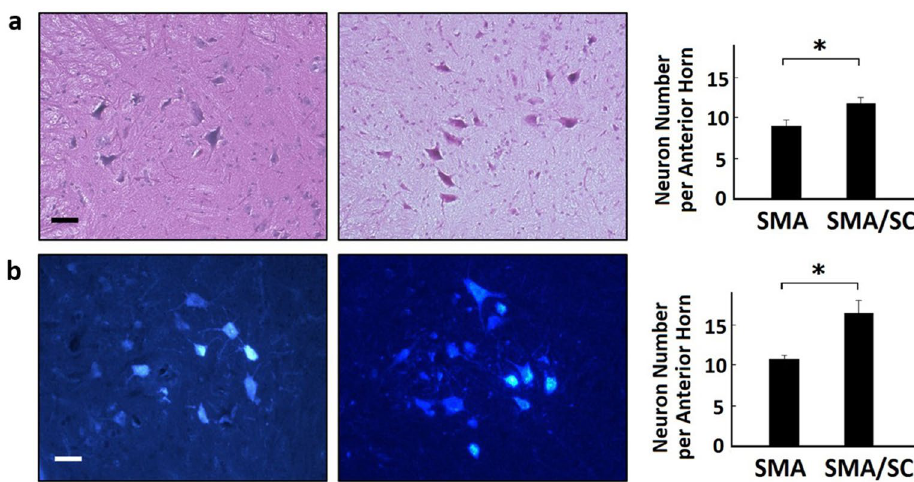
Figure 10. Comparison of neuron in SMA mice with or without hAFSC transplantation. n = 16. (a) H&E staining of tissue from spinal cord. (b) Methylene blue staining of tissue from spinal cord. More neurons per anterior horn were detected in SMA mice with hAFSC transplantation. hAFSC human amniotic fluid stem cell, SMA spinal muscular atrophy, SC stem